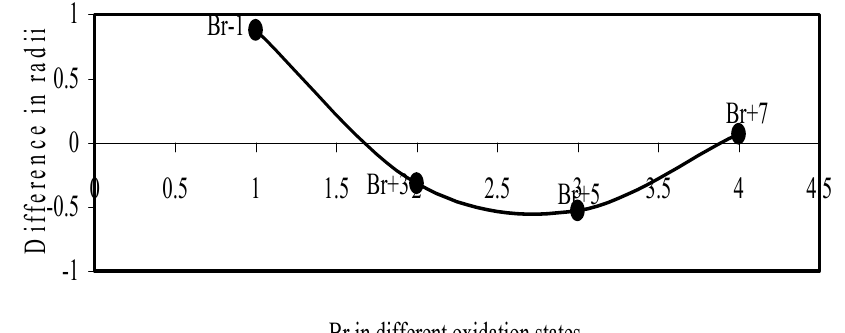
Figure 14. Plot of difference in experimental and theoretical radii of Br in different oxidation states